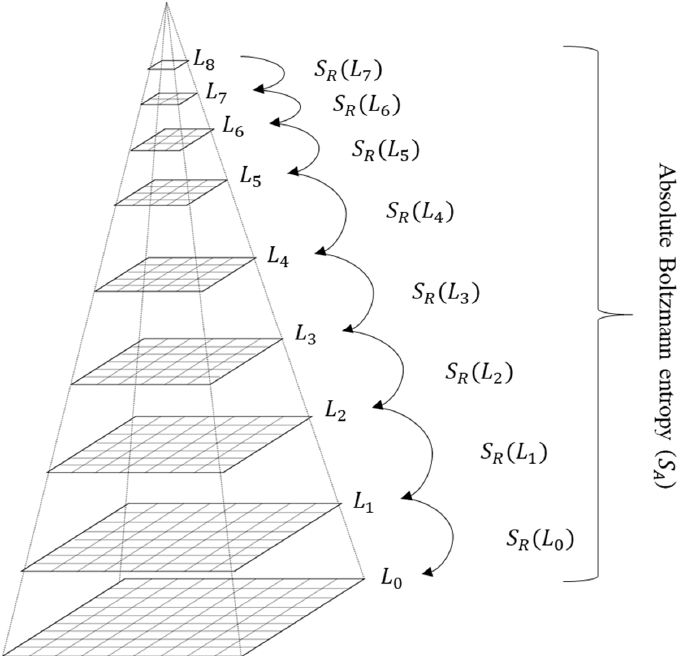
Figure 2. A visual representation of summing the relative Boltzmann entropies ( S R ) of all levels to get the absolute Boltzmann entropy ( S A ) of a landscape gradient (modified from Gao et al.